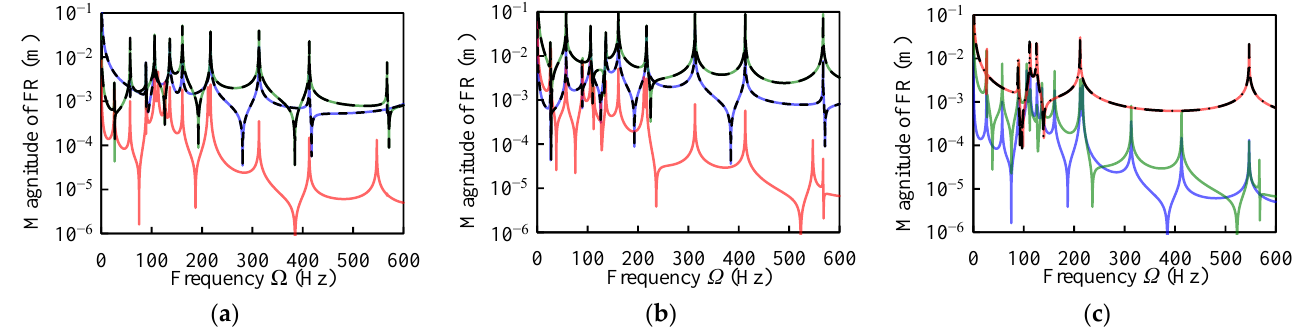
Figure 7. FR at the right end of the thin-walled beam with symmetrical and asymmetrical subsystems. ( W (with symmetrical systems), W (with asymmetrical systems), Ψ (with symmetrical systems) Ψ (with asymmetrical systems) V (with symmetrical systems), V (with asymmetrical systems)). ( a ) Force is applied in W direction; ( b ) Force is applied in Ψ direction; ( c ) Force is applied in V direction.